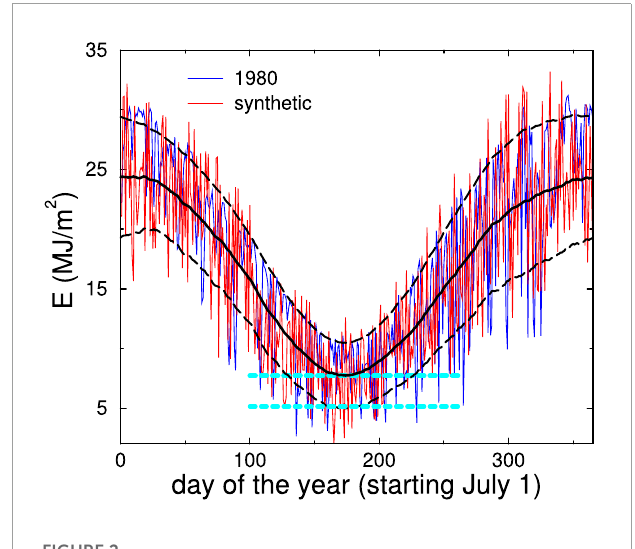
FIGURE 2 Insolation fluctuations. The black curve is smoothed 45-day average daily energy per unit area on the St. Louis region, 1980–2019 and the one standard deviation range is dashed. Also shown is the daily data for 1980 (blue) and a typical realization of our synthetic data (red). The upper dashed blue line corresponds to the load with f = 1 (see text for the definition of f ) and the lower corresponds to f = 1 . 5. The difference between the daily data and the dashed lines gives the daily energy surplus/deficit for these two f